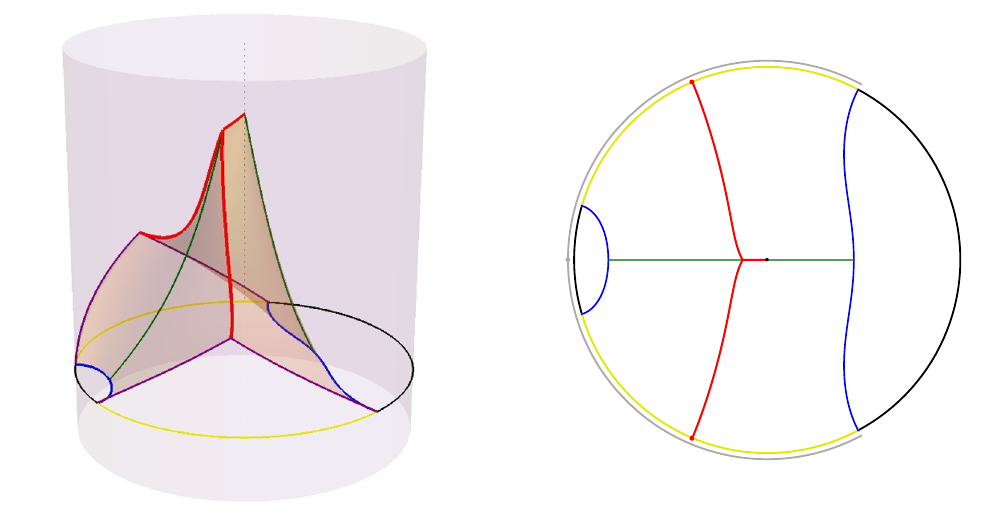
Figure 6. The entanglement wedge of a disconnected boundary region R , shown in yellow, on the constant time slice t = 0, for (cid:11) = 1 . The HRT surfaces are at r ( a ) = 0 : 8, r ( b ) = 3 : 5, (cid:18) ( a ) = 0, 0 0 0 2 : 2 (cid:18) ( b ) = (cid:25) and are shown in blue. The caustic, depicted in red, forms a Y-shape that is monotonically 0 decreasing in time as a function of r . The green lines represent the two radial light rays starting from the HRT surfaces and meeting the caustic. The purple lines bound the future boundary causal diamonds. Left. The complete entanglement wedge seen from the side. Right. The caustic seen from the top. The gray segment is a boundary region R 0 associated to (cid:13) ( a ) alone. The position of the tips of the boundary causal diamonds for the two interval boundary region are illustrated with red dots while the gray dot shows the position of the tip of the single causal diamond of region R 0